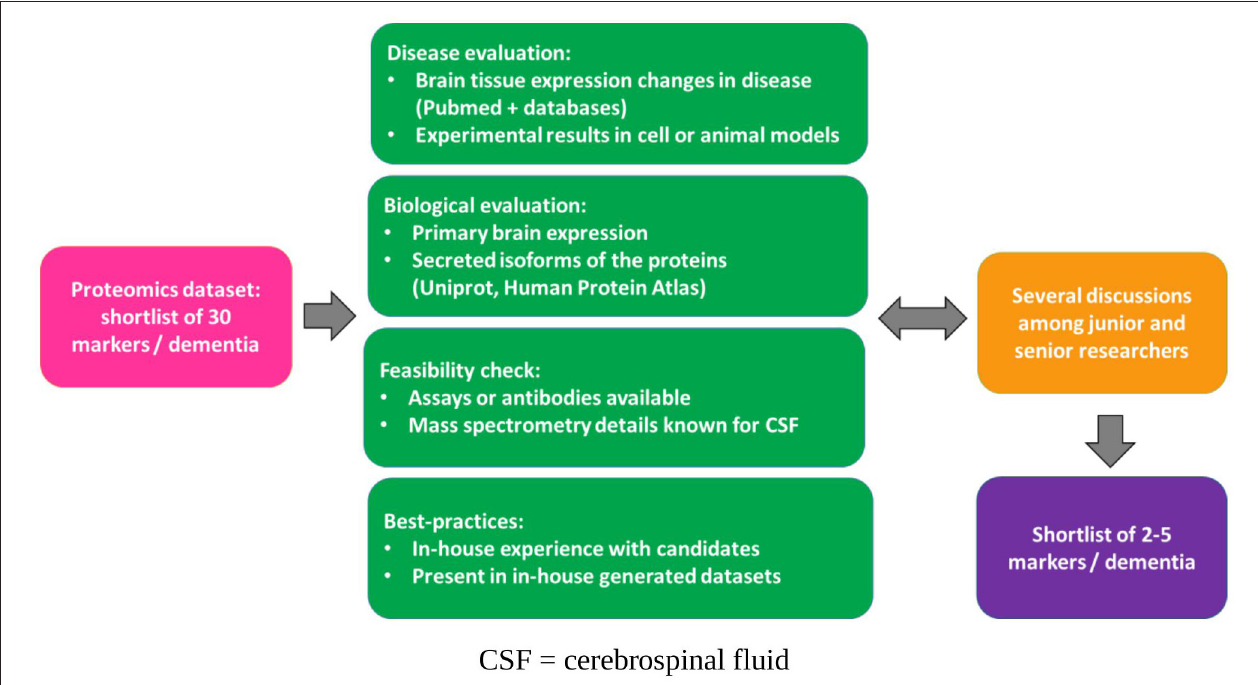
Frontiers in Neurology | www.frontiersin.org